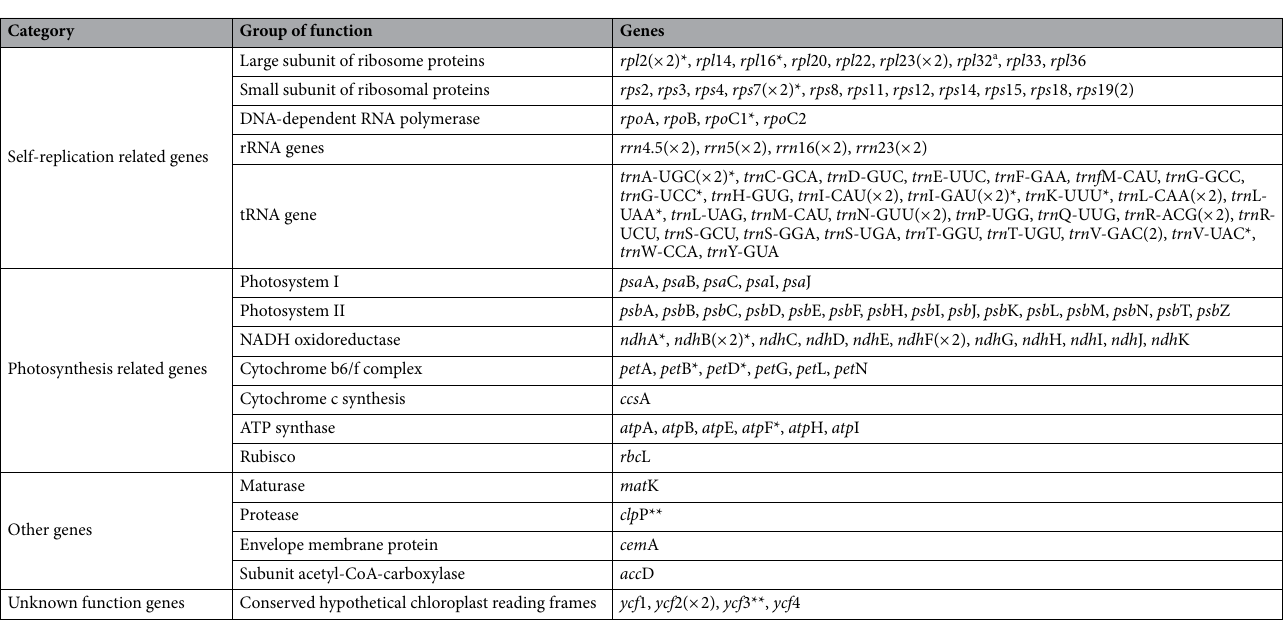
Table 2. Genes predicted in complete plastid genome of the five taxa of Cratoxylum used in this study. Genes that contain duplicates are indicated in parenthesis. *Indicates gene containing single intron; **Indicates gene containing two introns; a Indicates gene not found in Cratoxylum formosum subsp. formosum and C. formosum subsp.